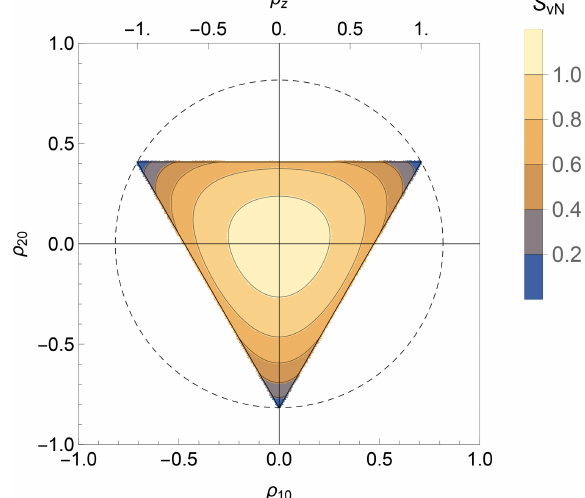
vN is shown as a contour plot against the rank-1 and rank-2 polarization moments for isolated spins-1, for the case of ρ λµ = 0 for µ (cid:54)= 0. Only the physical region is shown (see Fig. 1). The corresponding value of the z polarization p z = 2 1 / 2 ρ 10 is shown along the top edge. The maximum value of the von Neumann entropy, reached at the origin, is ln3 (cid:39) 1 .